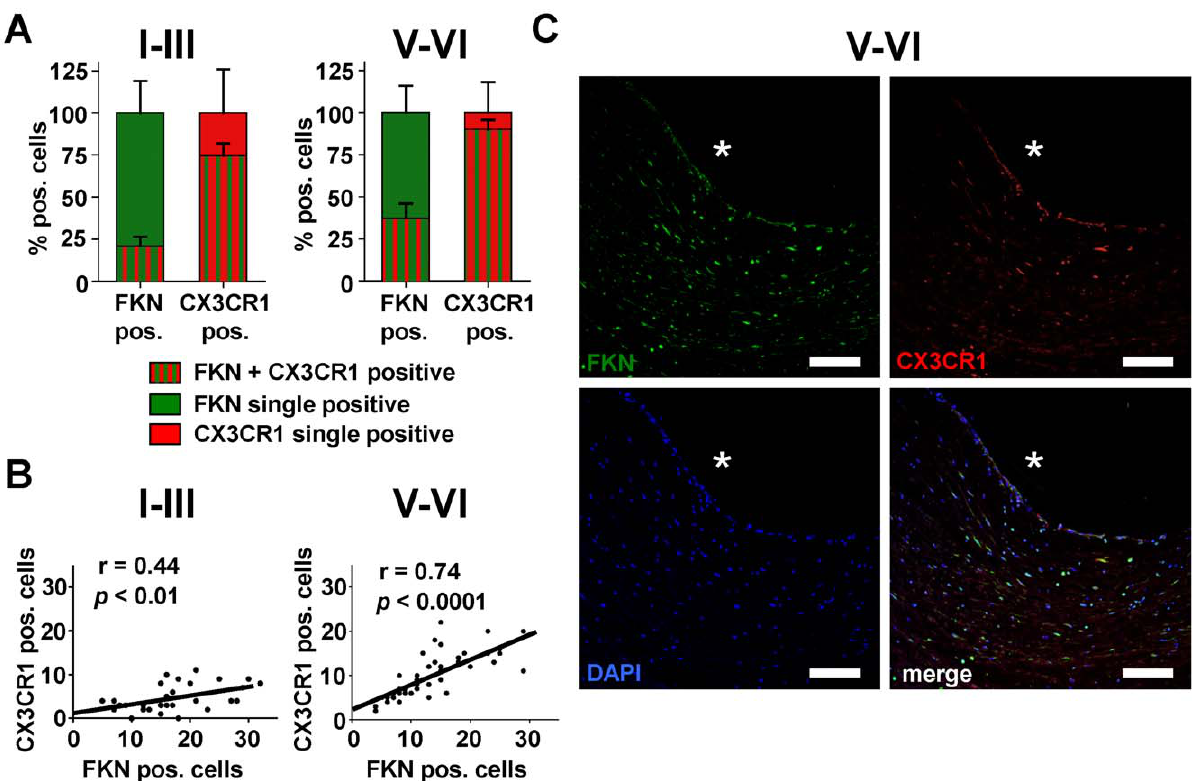
Figure 3. Double immunofluorescence analysis of FKN and CX3CR1 expressing cells. (A) Percent distribution of FKN (green) and CX3CR1 (red) single positive and double positive (red-green stripes) cells in early (I–III) and advanced (V–VI) plaque. n=4 carotids per group. (B) Quantitative analysis of the number of FKN and CX3CR1 positive cells in human carotid plaque. The correlation between the co-incidence of both markers was calculated by linear regression analysis. Upper panel: early plaque (I–III), r=0.44, p , 0.01. Lower panel: advanced plaque (V–VI), r=0.74, p , 0.0001. (C) A representative section from an atherosclerotic lesion (V–VI) was stained for FKN (green), CX3CR1 (red), and DAPI (blue). Bars, 100 m m. Asterisks indicate the luminal side of the vessel.